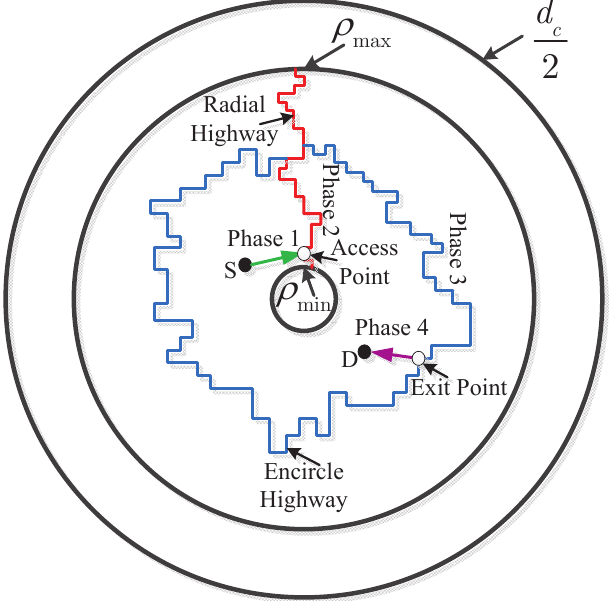
Figure 3. A schematic representation of the routing scheme. We omit the eavesdroppers in this